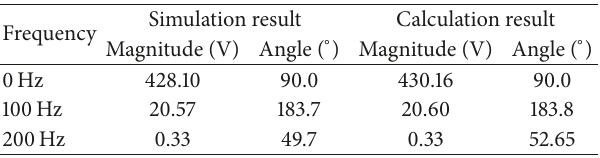
Table 3: Comparison of theoretical results and simulation results of harmonic voltages on dc